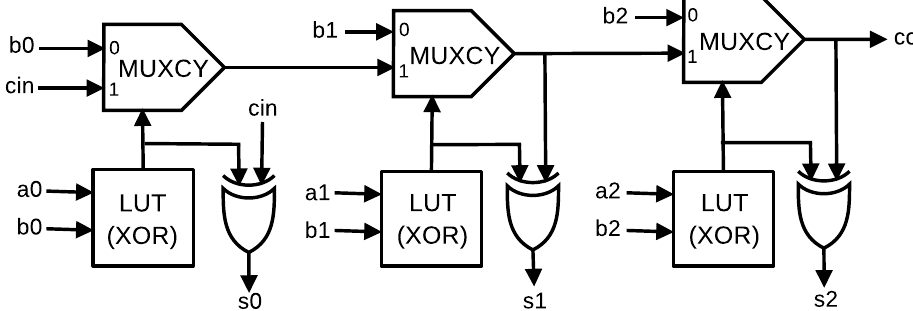
Figure 2. A 3-bit full adder implemented in a Xilinx FPGA device using carry chains.